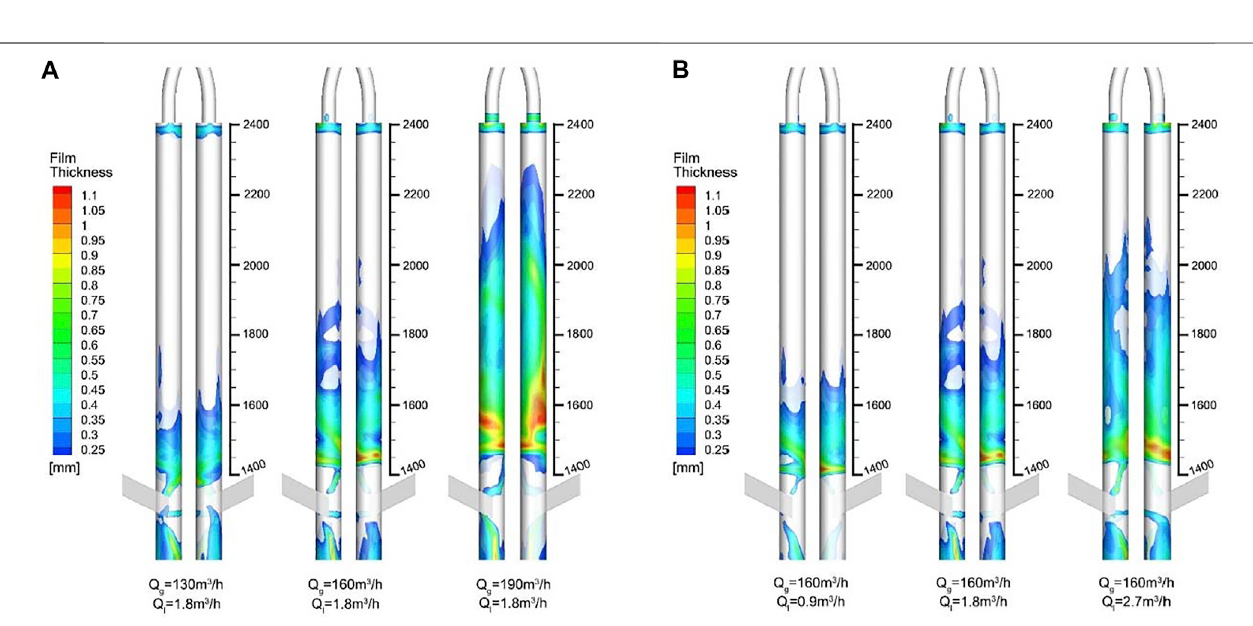
Frontiers in Chemical Engineering |